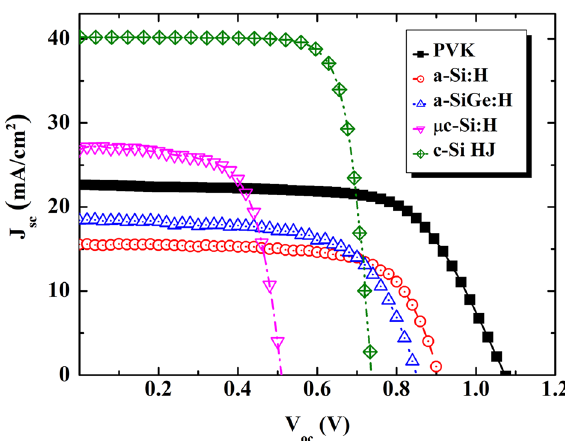
Figure 2. Illuminated current–voltage characteristics of the various top sub-cell candidates and standard-alone a-Si:H/c-Si heterojunction solar cell under 1 sun. The black, red, blue, magenta, and olive lines indicate the J-V curves for the PVK, a-Si:H, a-SiGe:H, μc-Si:H thin film solar cell and c-Si HJ solar cell,